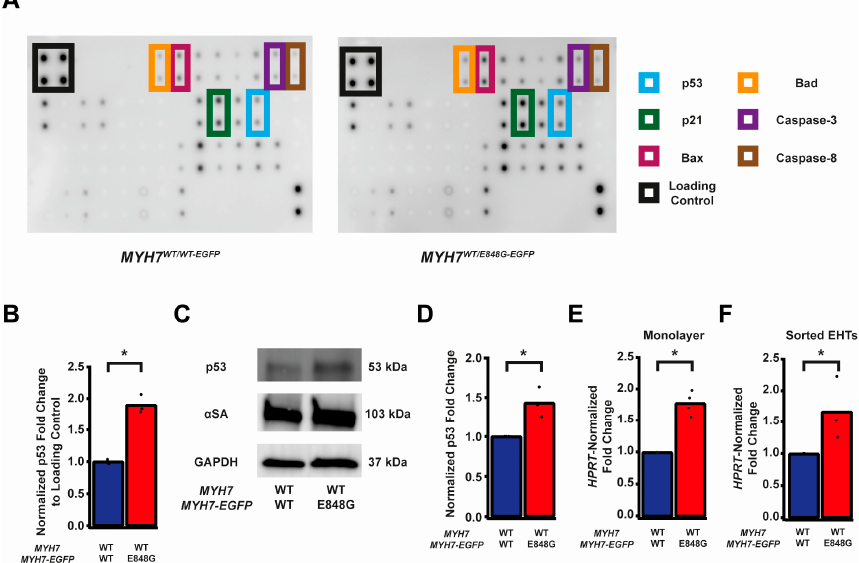
Figure 3. MYH7 E848G induces p53-associated intrinsic apoptosis in hiPSC-CMs cultured in a mon- olayer and EHT. ( A ) Human apoptosis antibody array for MYH7 WT/WT-EGFP and MYH7 WT/E848G-EGFP hiPSC-CMs, differentiation day 35, with select targets highlighted. ( B ) Quantification of protein ex- pression from ( A ) normalized to loading control and MYH7 WT/WT-EGFP . Mean and biological replicates shown, n = 3 technical replicates. ( C ) Representative Western blot for p53 and α -sarcomeric actinin ( α SA) protein expression in MYH7 WT/WT-EGFP and MYH7 WT/E848G-EGFP hiPSC-CMs, differentiation day 40. ( D ) Quantification of p53 protein expression from ( C ) normalized to α -sarcomeric actinin and MYH7 WT/WT-EGFP . Mean and biological replicates shown. ( E ) TP53 mRNA expression for MYH7 WT/WT- EGFP and MYH7 WT/E848G-EGFP hiPSC-CMs normalized to HPRT and MYH7 WT/WT-EGFP , differentiation day 40, as measured with RT-qPCR. Mean and biological replicates shown. ( F ) TP53 mRNA expression for MYH7 WT/WT-EGFP and MYH7 WT/E848G-EGFP EGFP + hiPSC-CMs sorted from cast week 1 EHTs, normal- ized to HPRT and MYH7 WT/WT-EGFP , as measured with RT-qPCR. Mean and biological replicates shown. * in ( B , D – F ) indicates p < 0.05 significance calculated with Student’s t -test.